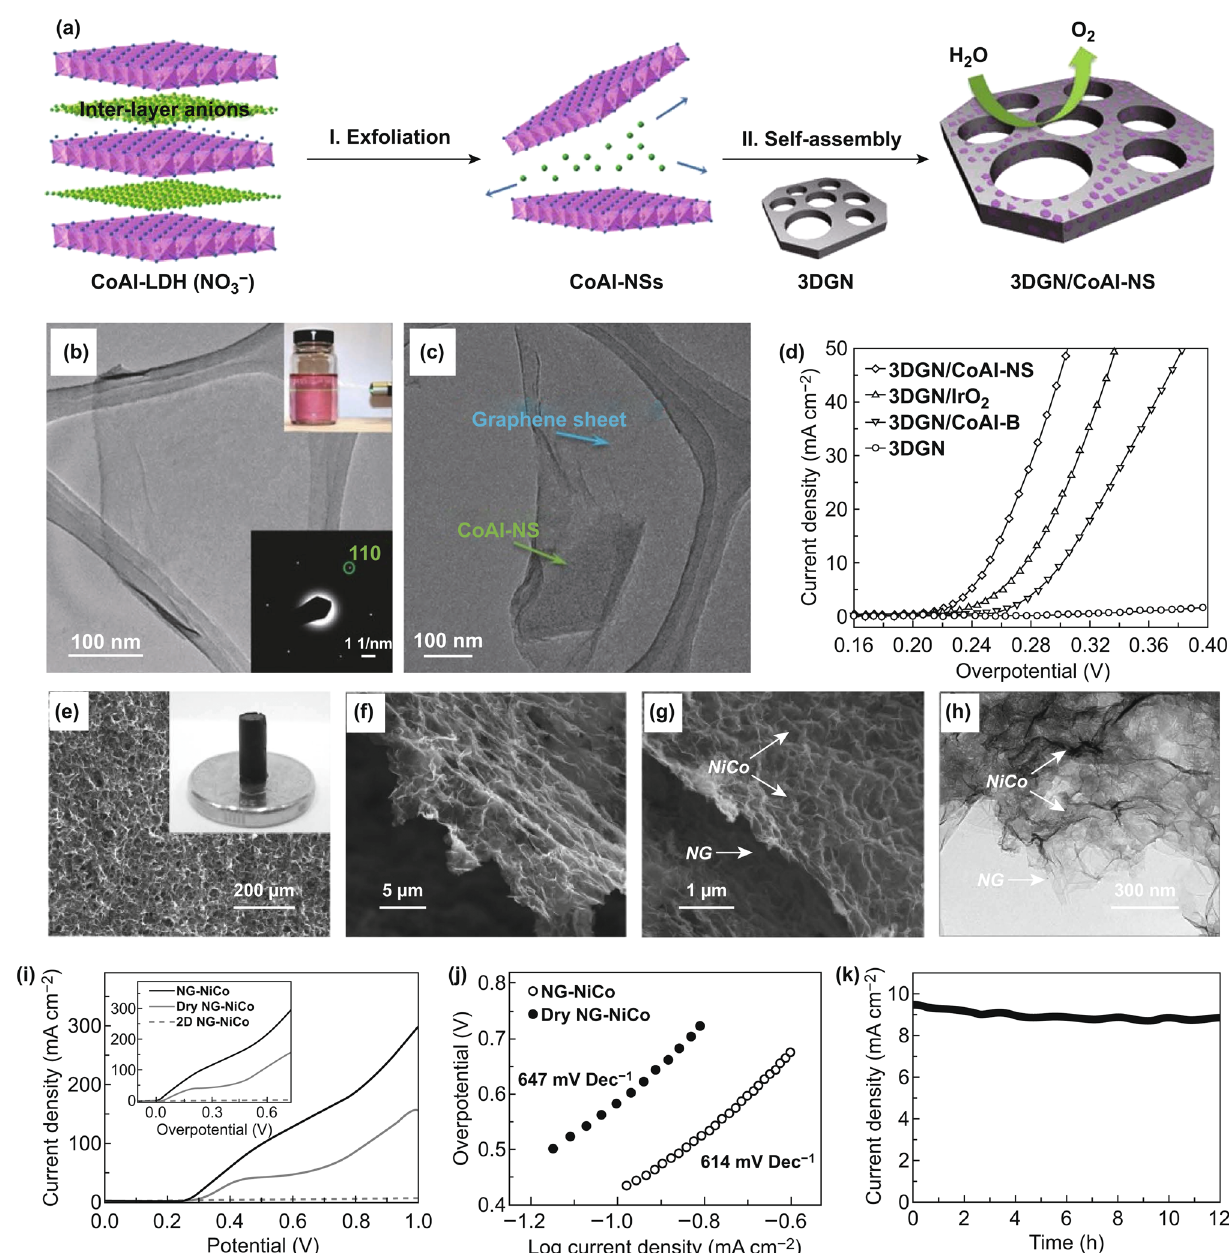
Fig. 14 a Schematic diagram of the fabrication of 3DGN/CoAl‑NS. b TEM image and SAED pattern (inset of b bottom) of the exfoliated CoAl‑NS, the inset (top) of b is photograph showing Tyndall effect of CoAl‑NSs solution under irradiation. c TEM image of 3DGN/CoAl‑ NS. d LSV curves of the catalysts at 1 mV s −1 in 1 M KOH. Reproduced with permission of Ref. [123]. Copyright 2016 WILEY–VCH Verlag GmbH& Co. KGaA, Weinheim. e – g SEM image and optical image (inset of e ), h TEM image of NG‑NiCo. i LSV curves of three catalysts at 50 mV s −1 in 0.1 M KOH. j Tafel plots for as‑prepared samples. k i – t curve of NG‑NiCo at 0.5 V versus Ag/AgCl. Reproduced with permission of Ref. [113]. Copyright 2013 WILEY–VCH Verlag GmbH& Co. KGaA,